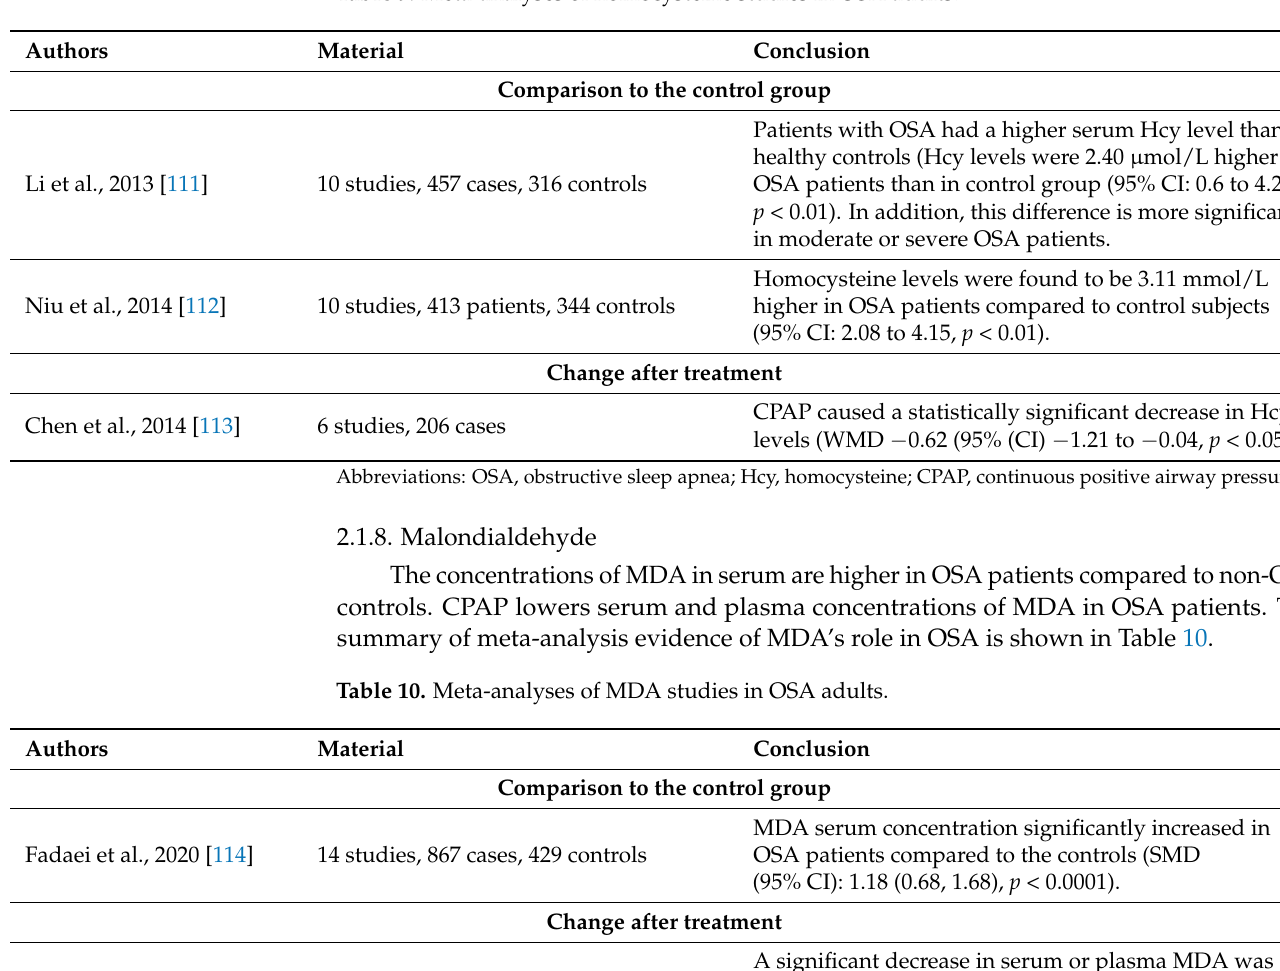
Table 9. Meta-analyses of homocysteine studies in OSA adults.